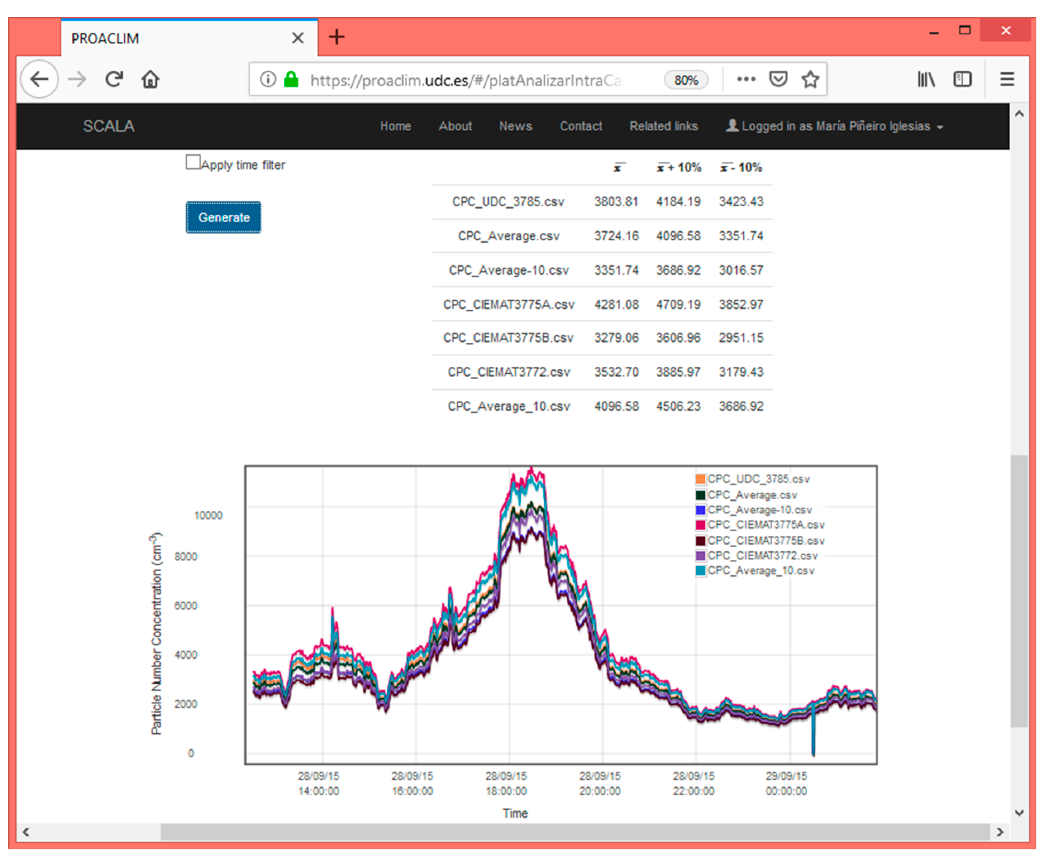
Figure 4. Evolution of the Particle number concentration (cm − 3 ) vs. Time (UTC) measured during the sampling period. It includes the measurements by the CIEMAT and UDC instruments, the average values and the +/ − 10% band.